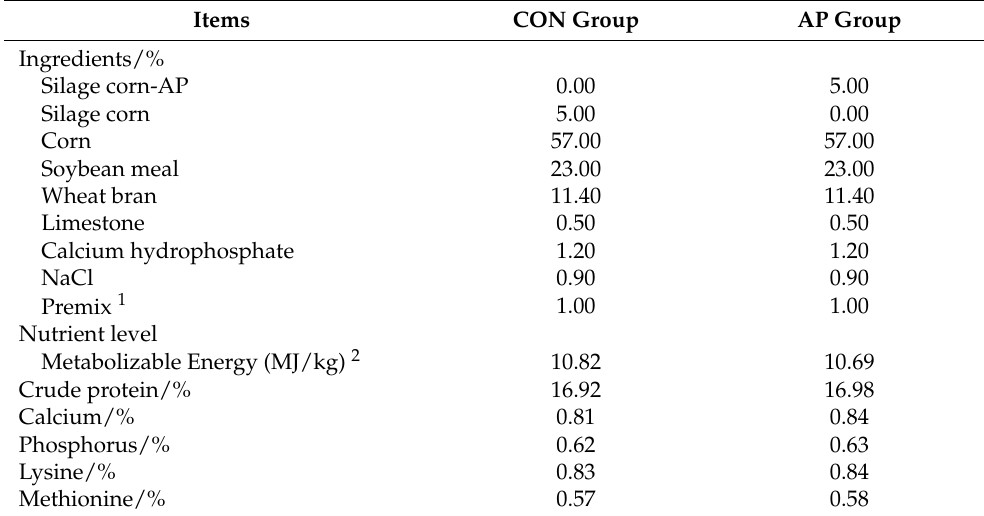
Table 2. Basic diet composition and nutrient levels of the CON and AP (apple pomace)